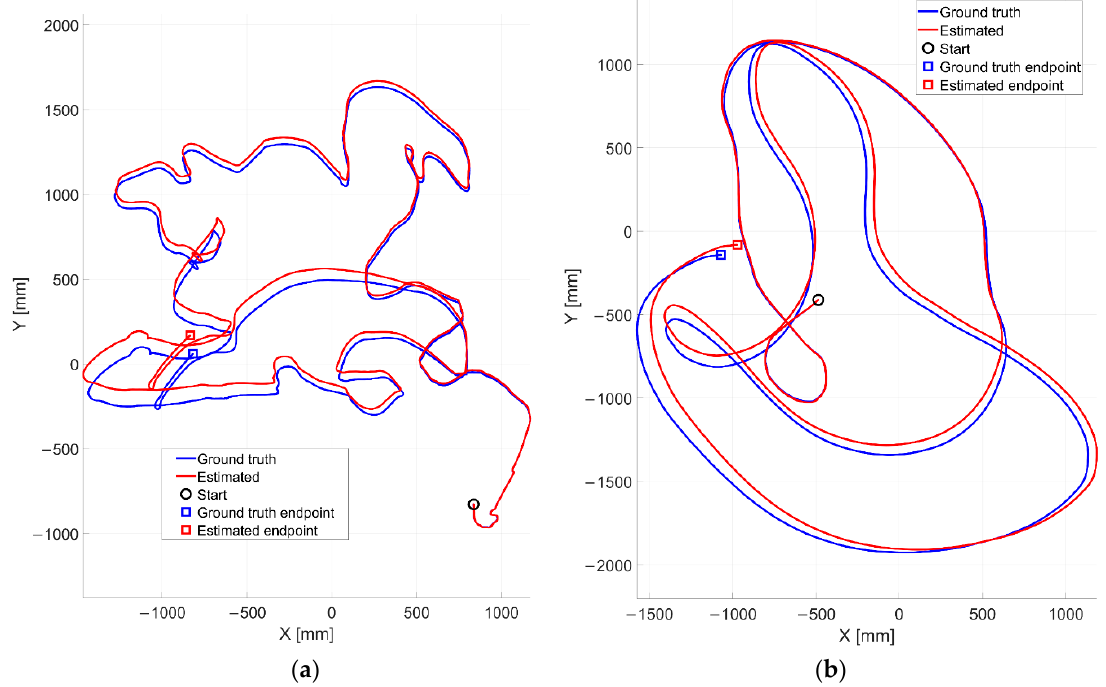
Figure 11. Estimated positions (in red) qualitatively compared with the ground truth ones (in blue) for ( a ) the experiment I and ( b ) the experiment II, both run at our robotics lab.